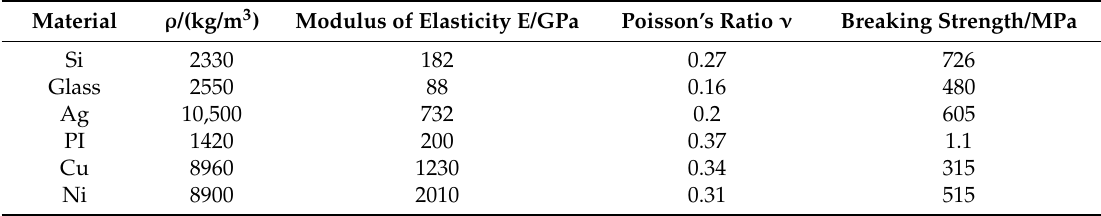
Figure 3. The silicon-based MEMS S&A device. Table 1. Material parameters of glass, silicon wafer and explosion suppression mechanism energy-absorbing layer materials of Ag, Cu, Ni and polyimide (PI).